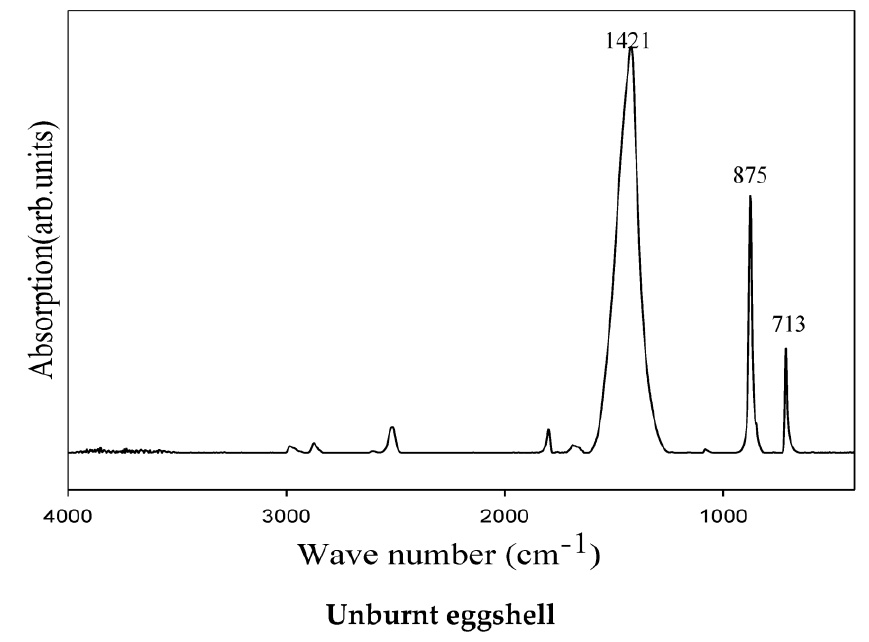
Figure 1. The X-ray Diffraction (XRD) spectrum of original ( top ) and incinerated ( bottom ) eggshell.